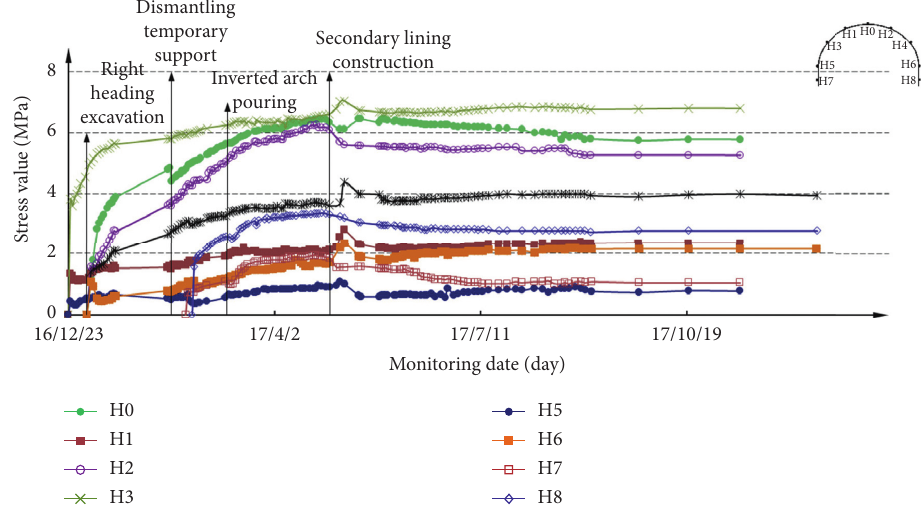
Figure 8: Stress temporal curve of shotcrete at section YK2+449.